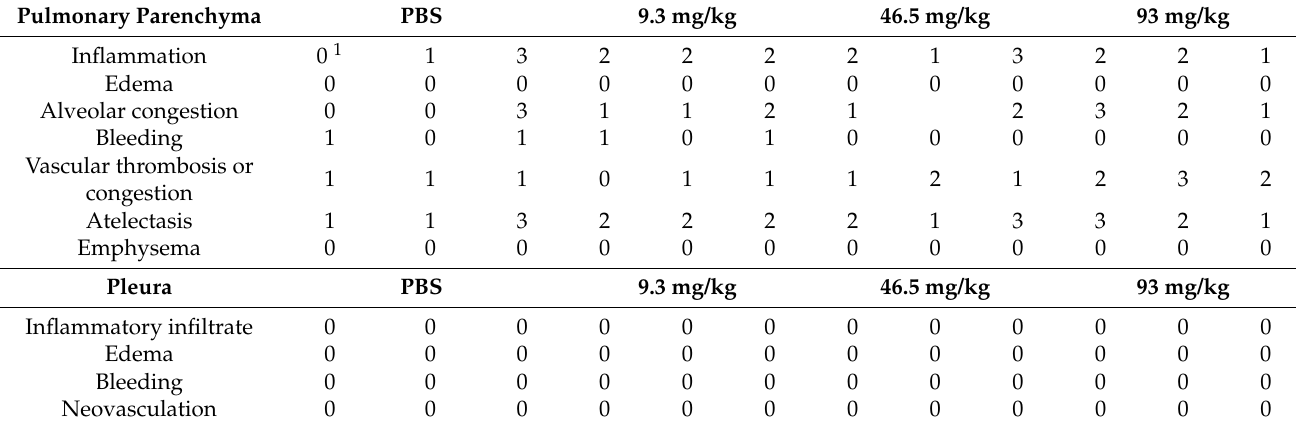
Table 1. Lung and pleura toxicity assay. The existence of injury in pulmonary parenchyma (inflammation, edema, alveolar congestion, bleeding, and vascular thrombosis or congestion) was evaluated in each biological sample. Pulmonary Parenchyma